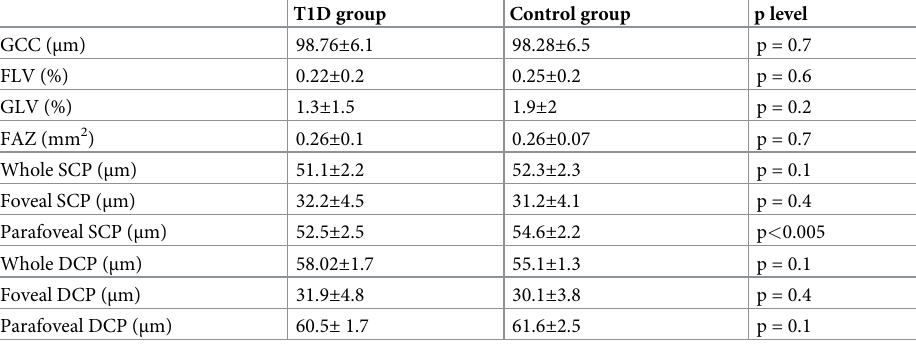
Table 2. Comparison of OCT and OCTA parameters between T1D and control